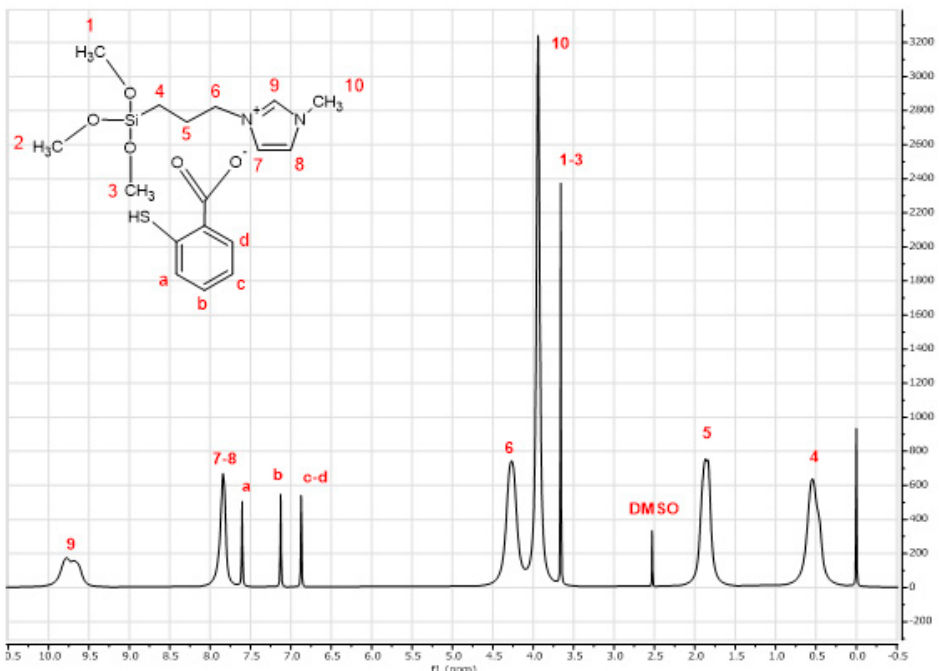
Figure 1. 1 H-NMR spectra of the newly synthesized 1-methyl-3-(3-trimethoxysilylpropyl) imidazolium thiosalicylate ([MTMSPI][TS]) ionic liquid.